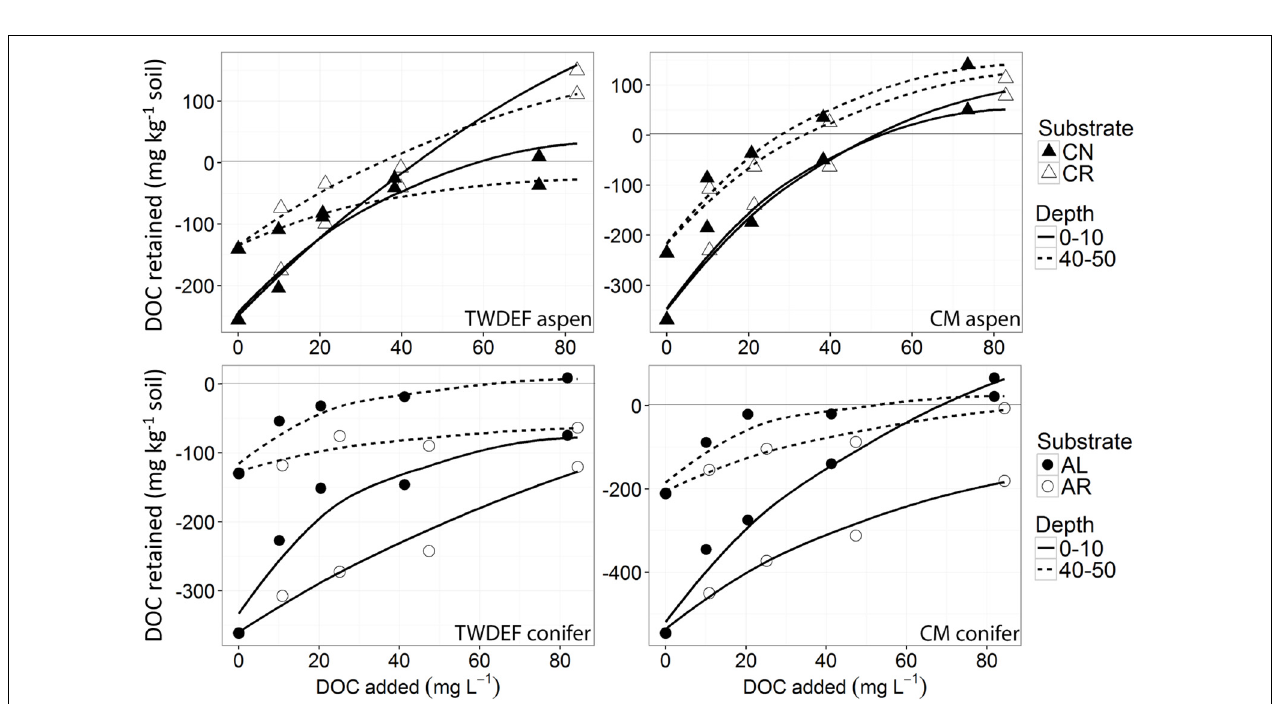
FIGURE 3 | Non-linear isotherms representing release/retention of dissolved organic carbon (DOC) from fir needles (CN) and fir roots (CR) on aspen soils (upper two graphs) , and of aspen leaves (AL) and aspen roots (AR) on conifer soils (lower two graphs) from TWDEF and CM sites. The y -axis indicates DOC retention in the area above zero, and DOC release in the area below the zero-line. The SE of laboratory replicates was mostly < 5%.